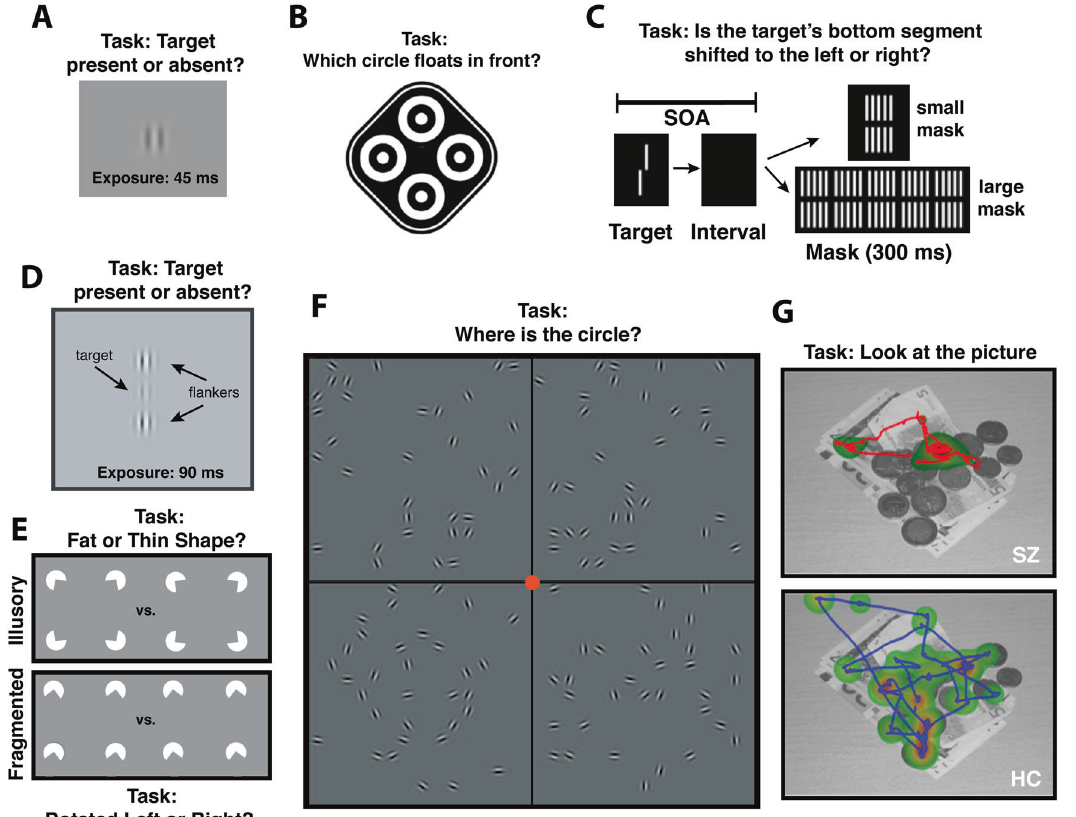
Fig. 1 Visual tasks that may elicit behavioral markers of early psychosis. A Never-medicated fi rst-episode psychosis patients (FEPs) have superior contrast sensitivity at lower spatial frequencies compared to healthy controls (HCs) [32]. B Never-medicated FEPs have a diminished ability to identify the circle that fl oats in stereo [35]. C FEPs need more of a temporal interval (SOA) between the target and a subsequent grid-like mask to achieve 75% accuracy on a Vernier discrimination task [42]. D Schizophrenia patients of varying illness durations bene fi t less from high-contrast collinear fl ankers when attempting to detect a central low-contrast target relative to healthy and clinical controls [45, 47]. E For FEPs, discriminating fat and thin illusory shapes is harder than discriminating left and right rotated pac-men; for HCs, the opposite is true [48]. F Compared to healthy controls, FEPs can tolerate fewer background “ noise ” elements when attempting to detect a circular chain of elements [50]. G Independently of illness duration, SZ patients exhibit spatially restricted eye movement patterns when freely viewing complex images which becomes apparent for spatially-scaled down (smaller) bene fi t normally from collinear fl ankers, the same is not true for displays ( d = 0.72, p < 0.05), cannot be explained by inattentive- clinically stable SZ outpatients [44]. The facilitation impairment ness since the same patients perform near ceiling on catch trials arises among SZ patients with intact attention, intact contrast (where the target was shown by itself) [50]. sensitivity, and 12-week medication washout periods [45, 46]. In a Eye movement differences also hold promise. Using a dot sample of 38 SZ patients (including 6 FEPs), the de fi cit did not vary fi xation and free-viewing task, a probabilistic neural network with illness duration [47]. A caveat is that the effect may be most classi fi er could distinguish healthy controls ( n = 148) and clinically apparent for elements that have a smaller Gaussian window stable SZ patients ( n = 150) with 94% accuracy. The group (width) or higher spatial frequency, perhaps because such stimuli bias processing toward unmyelinated long-range horizontal connections in early visual cortex [47]. In a shape completion task, four pac-men form a fat or thin shape or are individually rotated leftward or rightward (illusory and fragmented condition, respectively). SZ patients show more de fi cits in the illusory than fragmented condition (134 non- affective psychosis patients, 66 HCs; d = 0.67, p < 10 – 4 ) [48]. These impairments are larger in schizophrenia than in bipolar disorder [49] and emerge maximally by the fi rst psychotic episode (23 FEPs, 48 HCs; p < 0.01, d = 0.74) [48]. Note that because the shape blamed on inadequate attention, motivation, visual acuity, or orientation discrimination. FEPs are also impaired at locating chains of co-aligned edge elements embedded within varying amounts of randomly oriented “ noise ” elements [50]. This contour integration de fi cit,